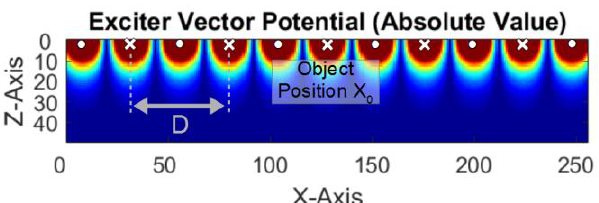
Figure 4. Top view of the vector potential ( 𝑨 𝐸 ) from a quasi-infinite undulating exciter; the white dots and crosses symbolize the alternating current directions.